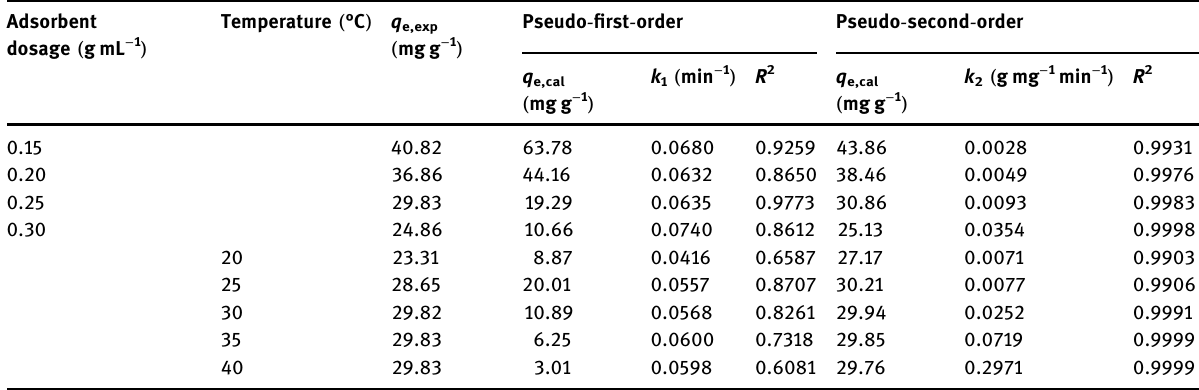
Table 1: Kinetic parameters for the adsorption of GPC on resin 001 × 7 based on the pseudo - fi rst - order and pseudo - second - order kinetic equations at di ff erent adsorbent dosages and temperatures Adsorbent dosage ( g mL − 1 )